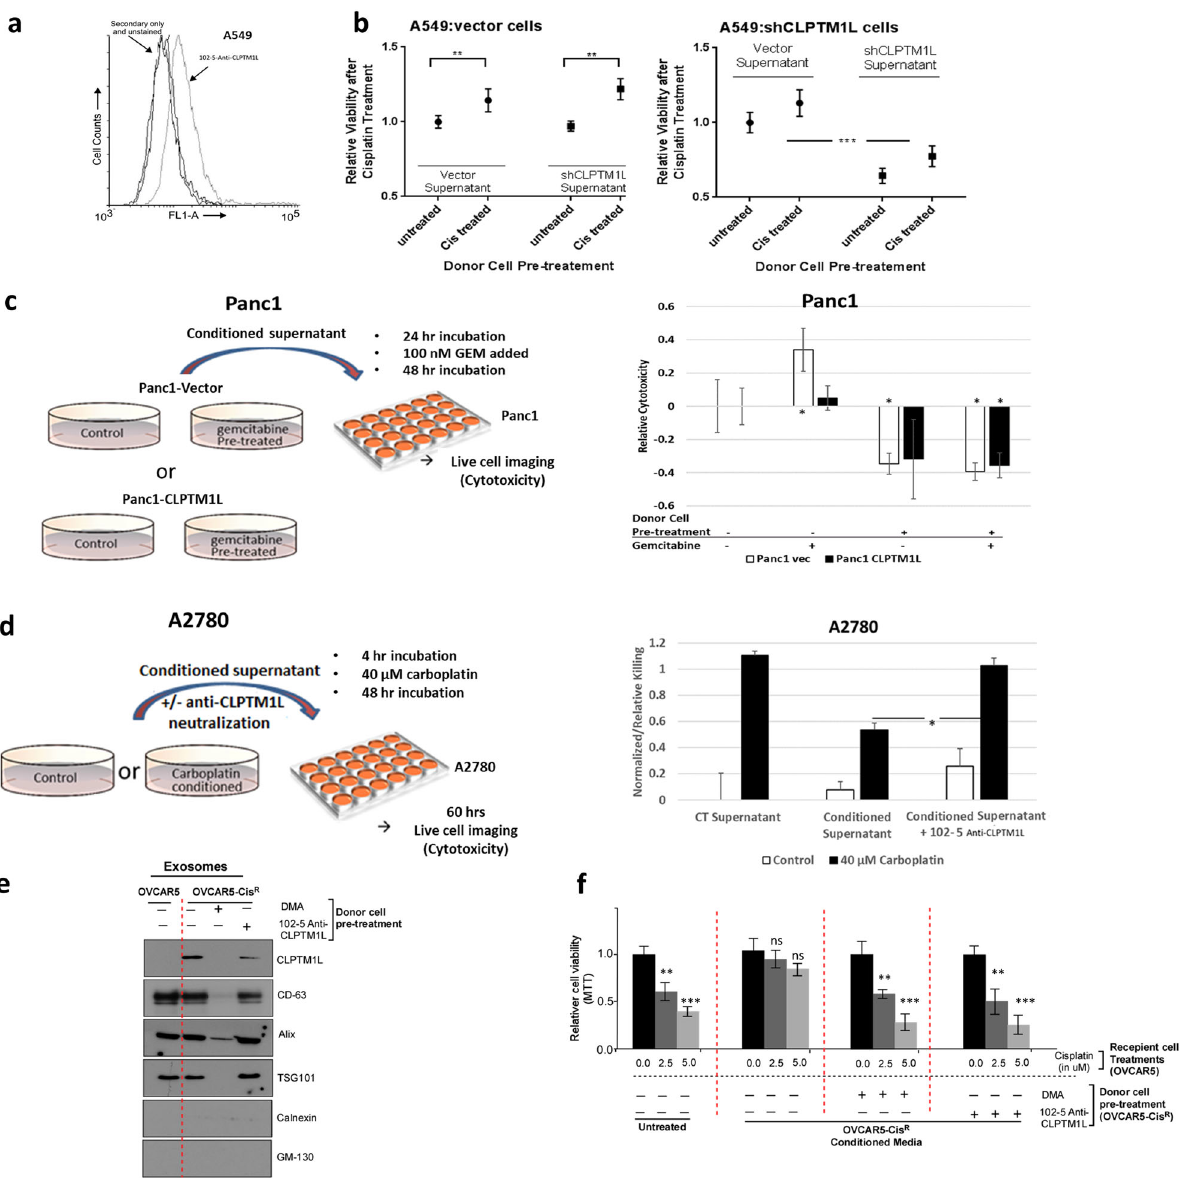
Fig. 3 Chemoprotection by culture supernatants. a Flow cytometry histograms of fl uorescent labeling of live A549 cells with 102-5 anti- CLPTM1L primary and Alexa fl uor-488-conjugated secondary antibodies. b Relative viability (MTS) of A549 cells (vector control, or with CLPTM1L shRNA knockdown (shCLPTM1L) after exposure to cisplatin and culture supernatants from either vector control or CLPTM1L shRNA cells that were untreated or pre-treated with cisplatin ( x axis). Error bars represent standard error of the mean. ** p = 0.003, *** p = 0.0001. c Relative killing (live imaging cytotoxicity) of Panc1 pancreatic tumor cells after 24-h treatment with 100 nM gemcitabine and 72-h culture supernatants that were either untreated or pre-treated with 20 nM gemcitabine. Error bars represent standard error of the mean. d Relative killing by 40 µM carboplatin (live imaging cytotoxicity) of ovarian tumor cells treated with supernatants from control or 10 µM carboplatin- conditioned A2780 donor cells at 60 h post-carboplatin treatment. Supernatants in the 102-5 groups were pre-treated with 100 nM 102-5 anti- CLPTM1L overnight. Error bars represent standard error of the mean. * p < 0.05, ** p < 0.005. e OVCAR5 – Cis R cells were treated with or without DMA or 102-5 Anti-CLPTM1L and western blotting was performed from the exosomes isolated from the conditioned media using indicated antibodies. f Results of cell viability assays performed on OVCAR5 cells treated with or without cisplatin that were untreated or pre-treated with culture supernatants of OVCAR5-Cis R cells with or without DMA or 102-5 Anti-CLPTM1L ( x axis). Error bars represent standard error of the